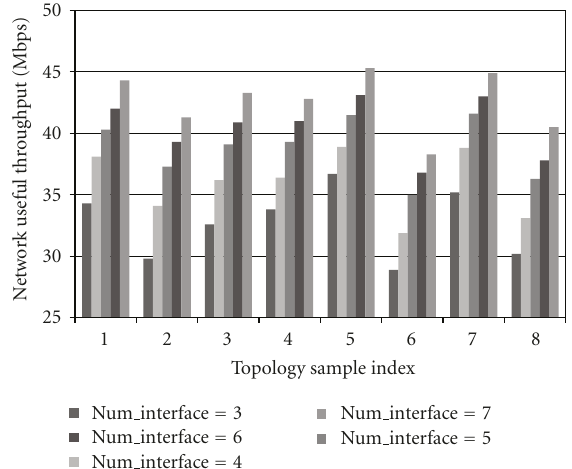
Figure 9: Comparison on the total useful throughput using di ff er- ent number of interfaces across 8 randomly generated